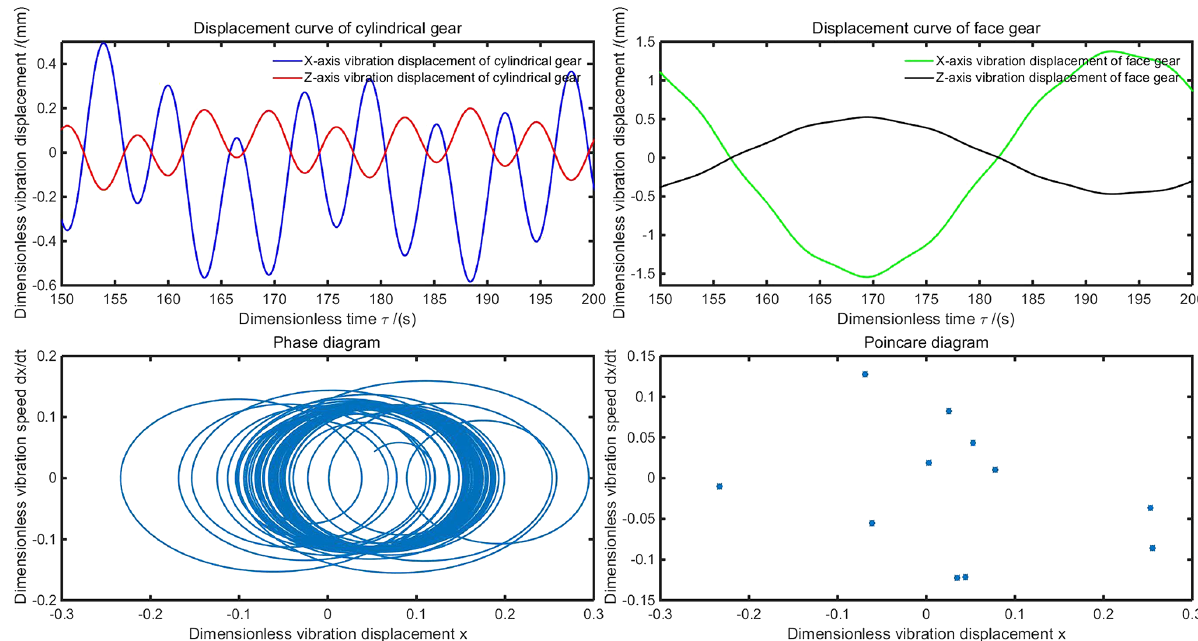
Figure 17. Displacement, phase, and Poincare diagrams of 3rd stage face gear pair nonlinear system.